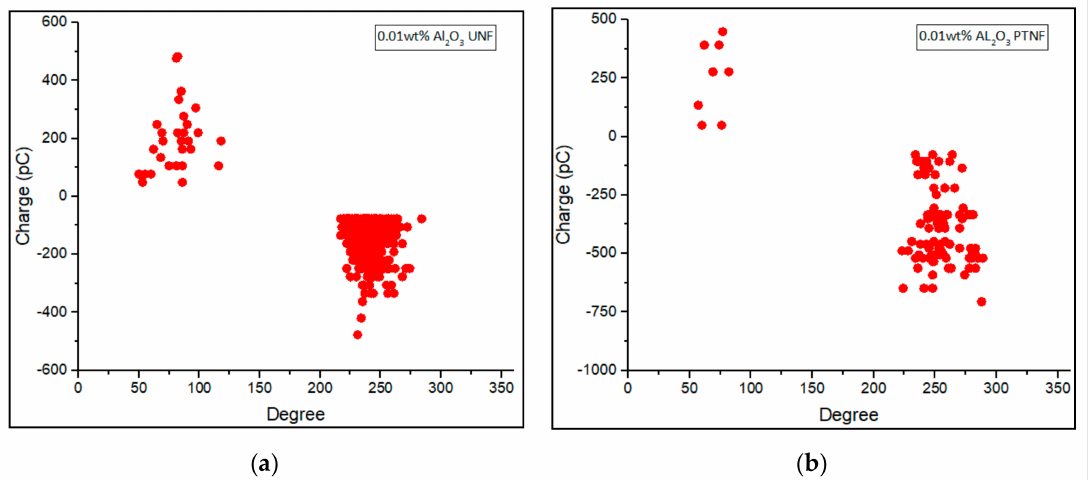
Figure 8. Phase—resolved PD patterns of ( a ) 0.01 wt% Al 2 O 3 UNF and ( b ) 0.01 wt% Al 2 O 3 PTNF.